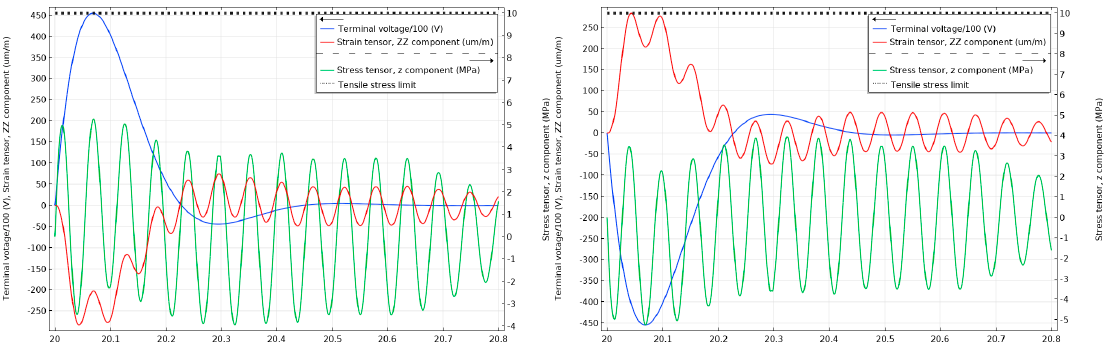
Figure 14. Stress and strain in the undamped stack when subjected to 1.2/50 µs 75 kV positive ( left ) and negative lightning impulses ( right ). The tensile stress limit of 10 MPa is marked by a black dotted line (the terminal voltage is the voltage applied to the top electrode of the stack.).